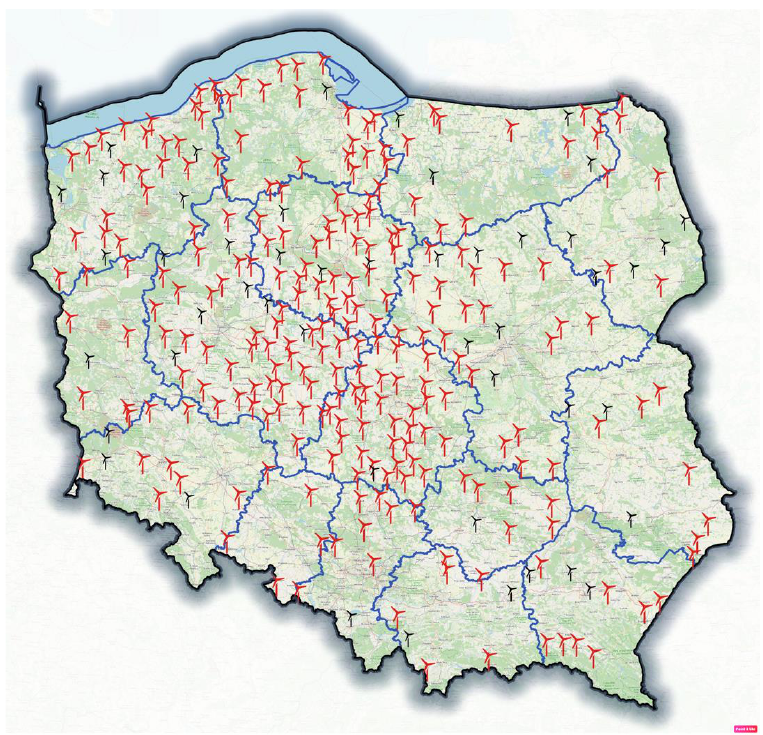
Figure 5. Localisation of wind parks (1290 pieces) and single turbines (283 pieces) in Poland.